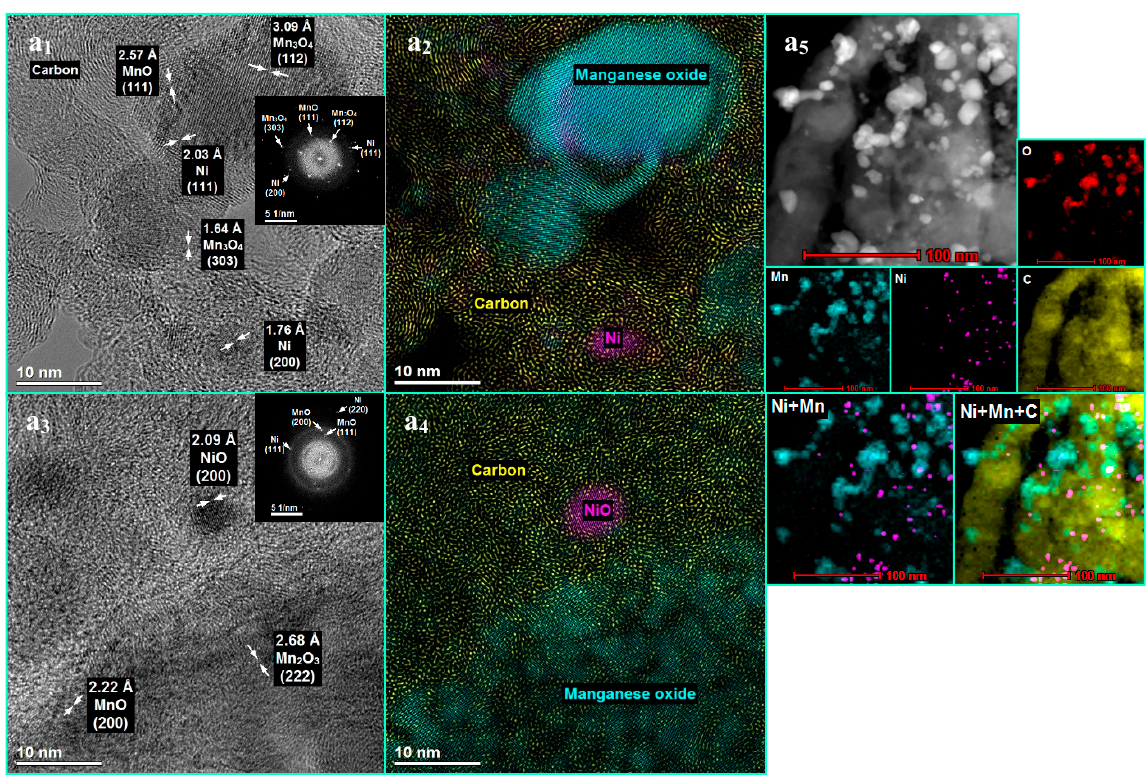
Figure 8. Microscopic analysis of KNi/MnO x catalyst after 18 h of SRE reaction at 420 °C for ( a ) H 2 O/EtOH molar ratio of 12/1 and ( b ) H 2 O/EtOH molar ratio of 4/1. SEM images ( a 1 , b 1 ) and TEM images ( a 2 , a 3 , b 2 , b 3 ).